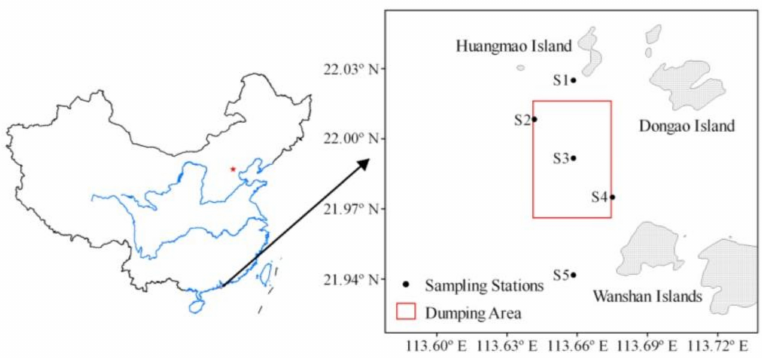
Figure 1. Sampling stations at the dumping area and adjacent sea